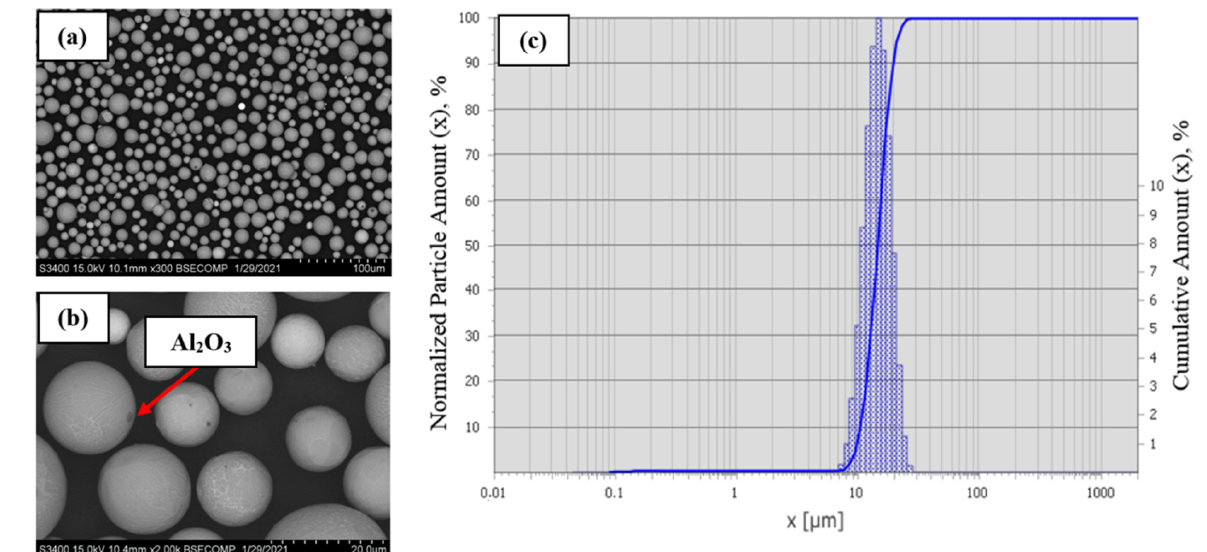
Figure 22. The morphology ( a , b ), differential, and integral distribution ( c ) of the spherical powder of the NiAl–Cr– Co+15%Mo alloy produced in the efficient treatment regime.